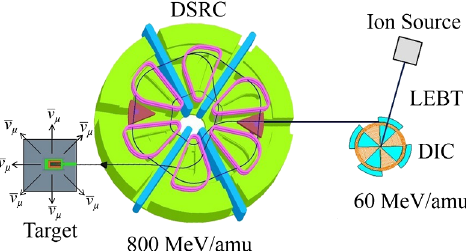
FIG. 8. Schematic of the DAE δ ALUS facility. H þ 2 is produced in the ion source, transported to the DAE δ ALUS Injector Cyclotron (DIC) and accelerated to 60 MeV = amu. Ions are subsequently extracted from the cyclotron and injected into the DAE δ ALUS Superconducting Ring Cyclotron (DSRC), where they are accelerated to 800 MeV = amu. During the highly efficient stripping extraction, 5 emA of H þ 2 becomes 10 emA of protons which impinge on the neutrino production